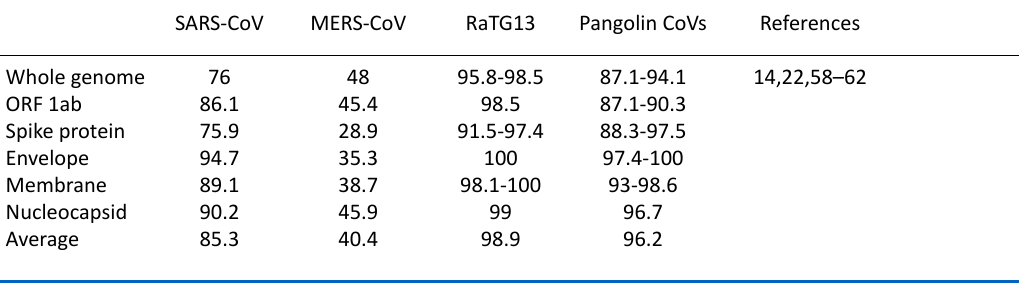
Table 1. Amino acid sequence similarity in % of selected coronaviruses to SARS-CoV-2